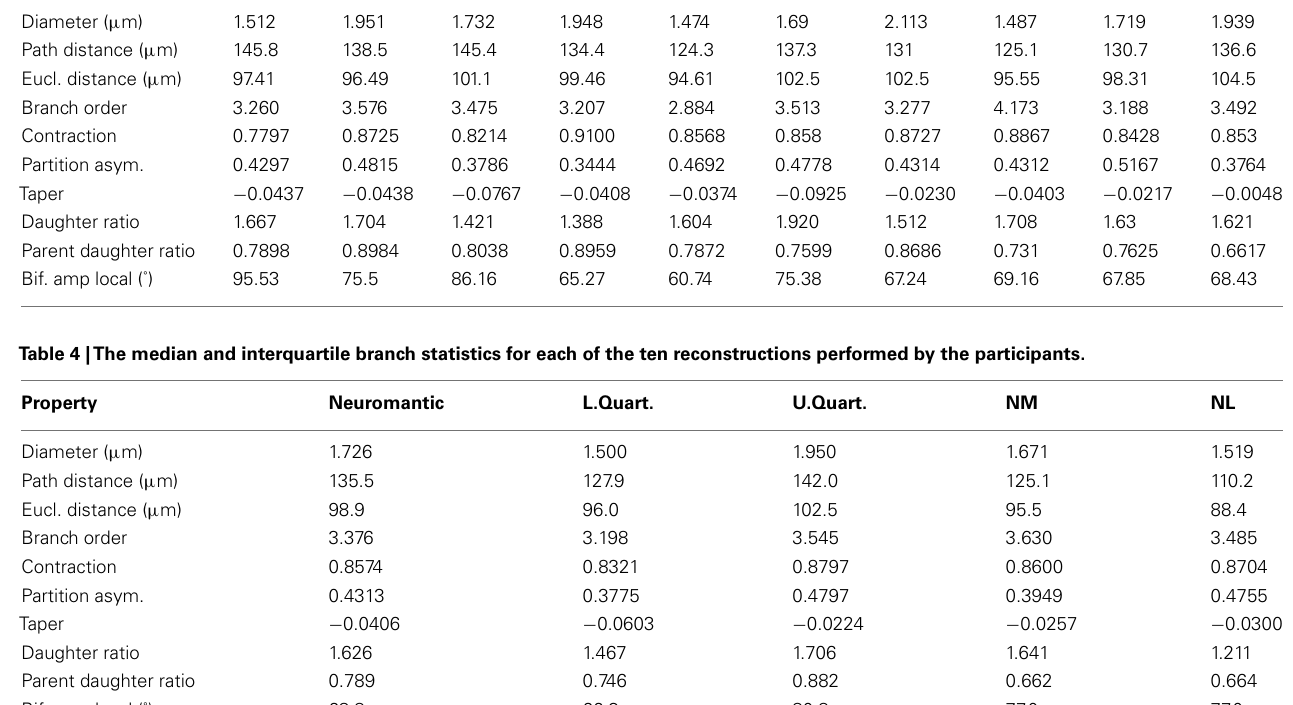
Table 3 |The mean branch statistics for each of the ten reconstructions performed by the participants. Measure (mean)